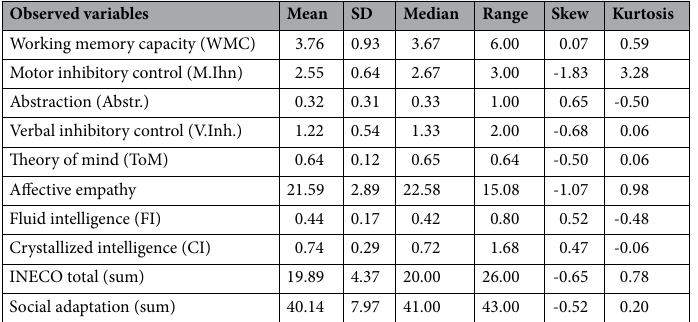
Table 2. Descriptive statistics of the model variables. With exception of INECO total and Social adaptation, the remaining observed/measured variables were calculated as mean across items.